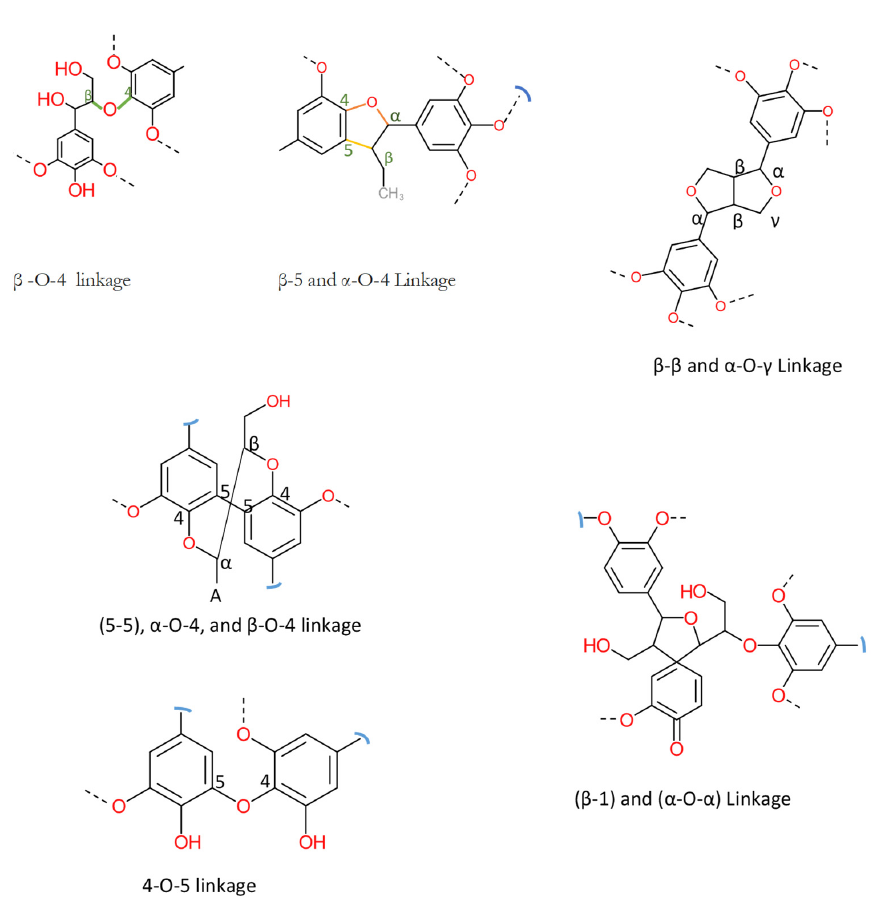
Figure 3. Common linkages found in lignin [18]. Table 1. Lignin from different sources and different chemical bonding [18].